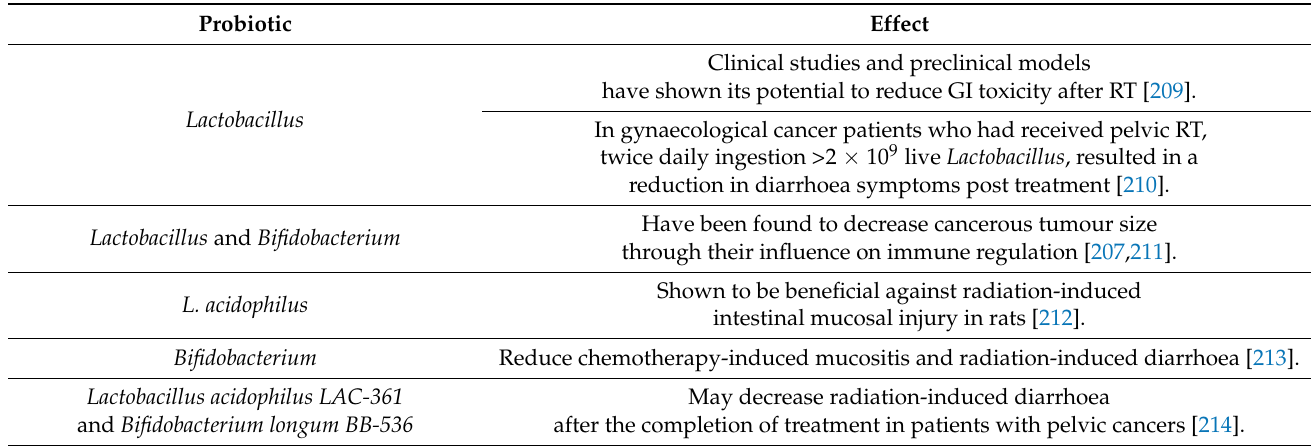
Table 12. Probiotics used in post-radiotherapy